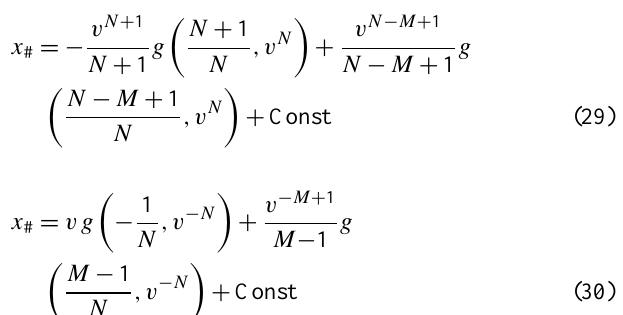
Fig. 1. A plot of the y c -based dimensionless 1-D GVF profiles for M = 3 and N = 10 / 3 with y c / y n as a